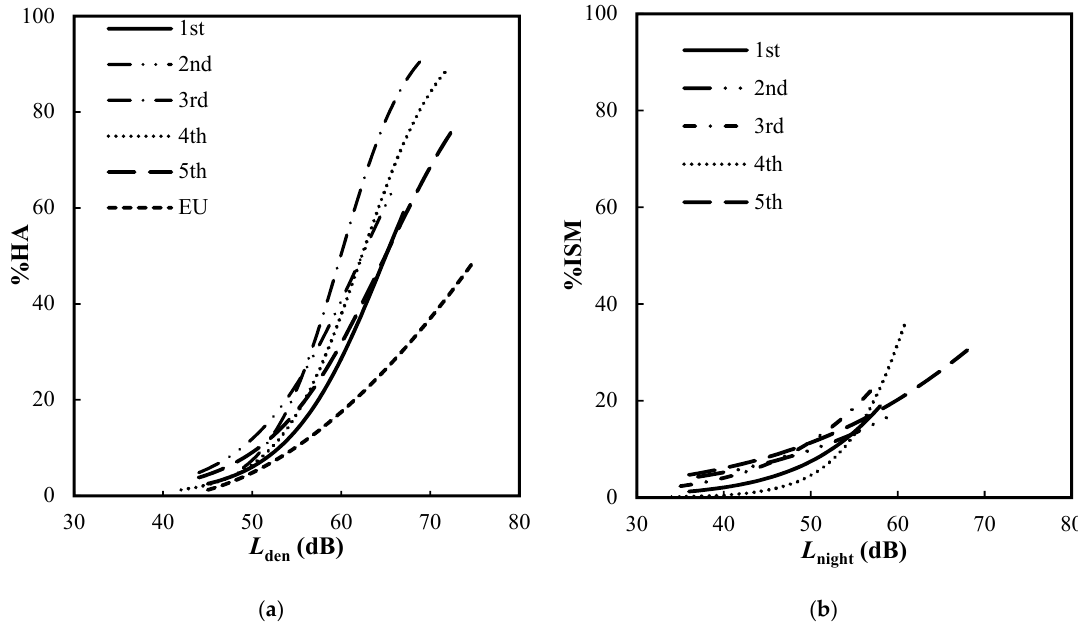
Figure 2. Comparison of the relationships synthesized from the data of each survey from 2014 to 2018. ( a ) L den –% HA relationships; ( b ) L night –% ISM relationships.